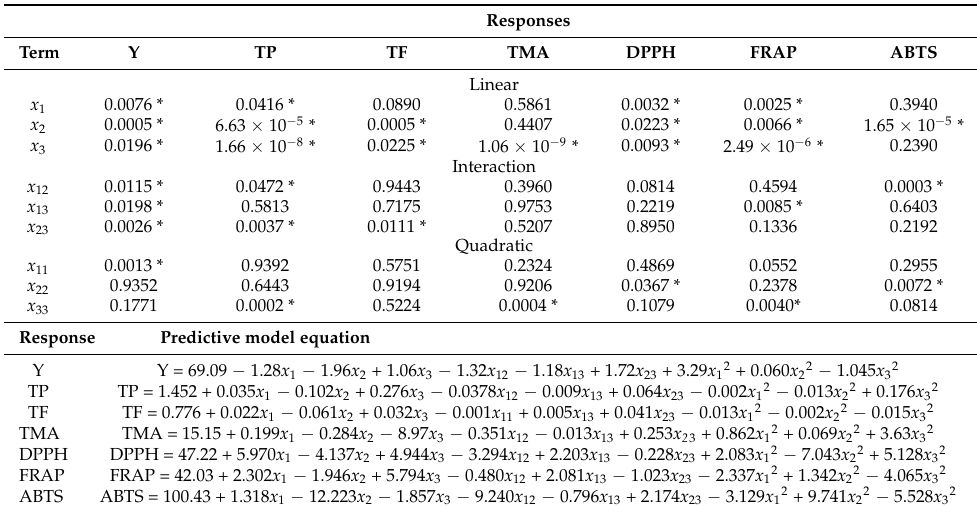
Table 4. Corresponding p values for regression coefficients from the second-order polynomial model and predictive model